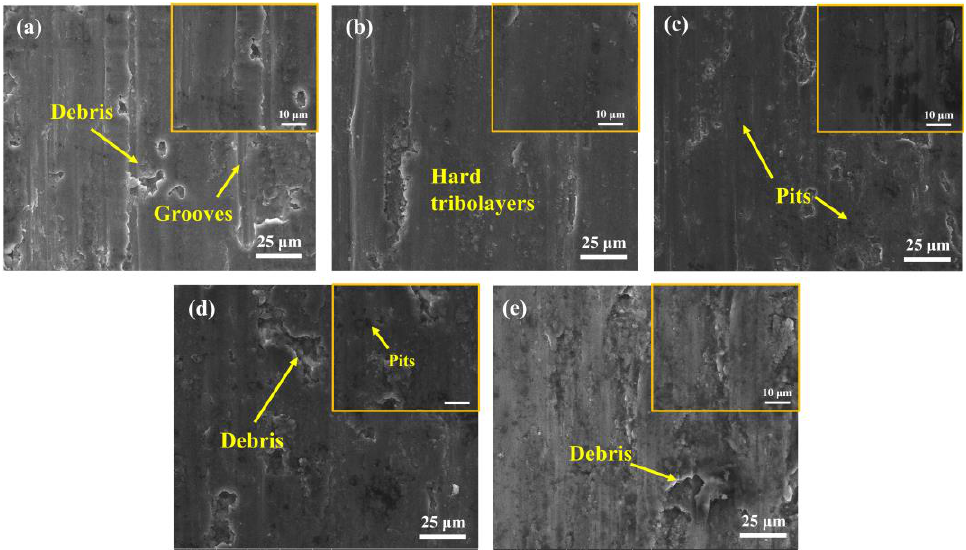
Figure 15. Wear surface morphologies of ( a ) S0; ( b ) S1; ( c ) S2; ( d ) S3; ( e )